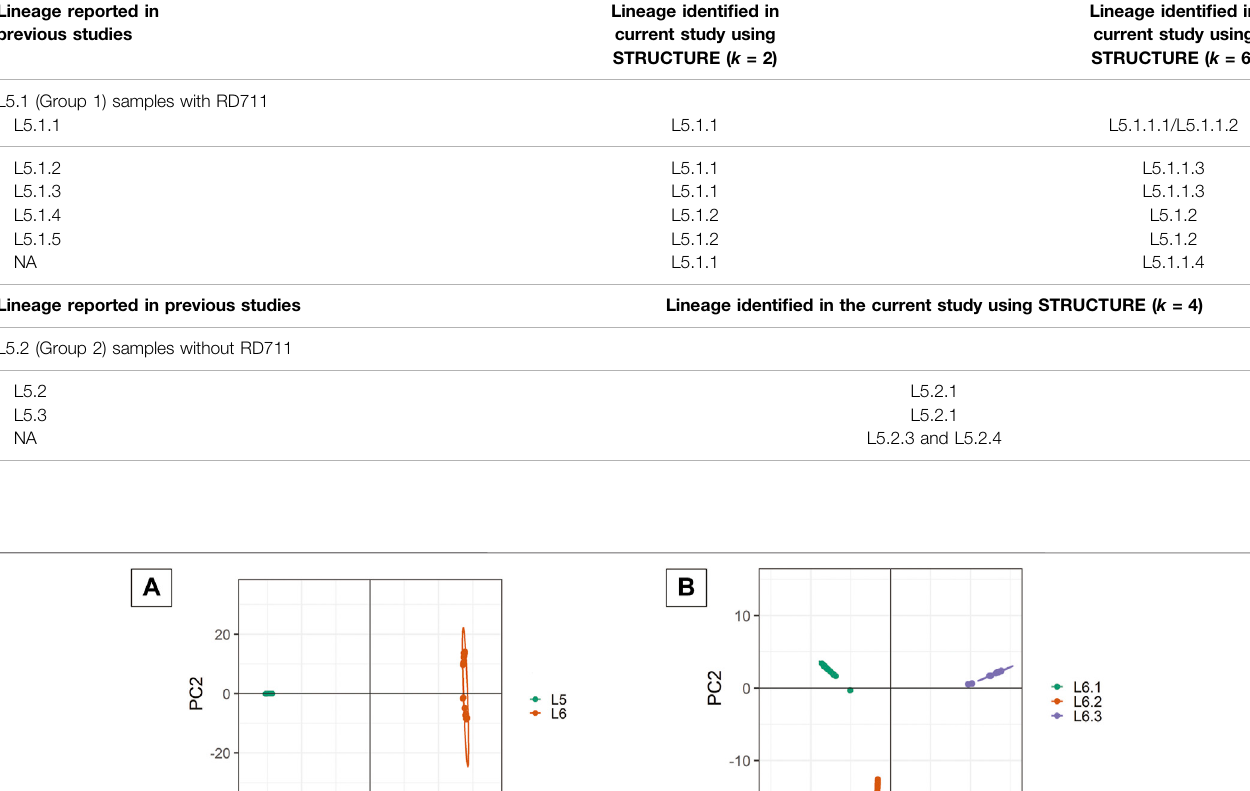
TABLE 2 | Comparison of L5 (sub)-lineage mapping with previous studies. Lineage reported in previous studies